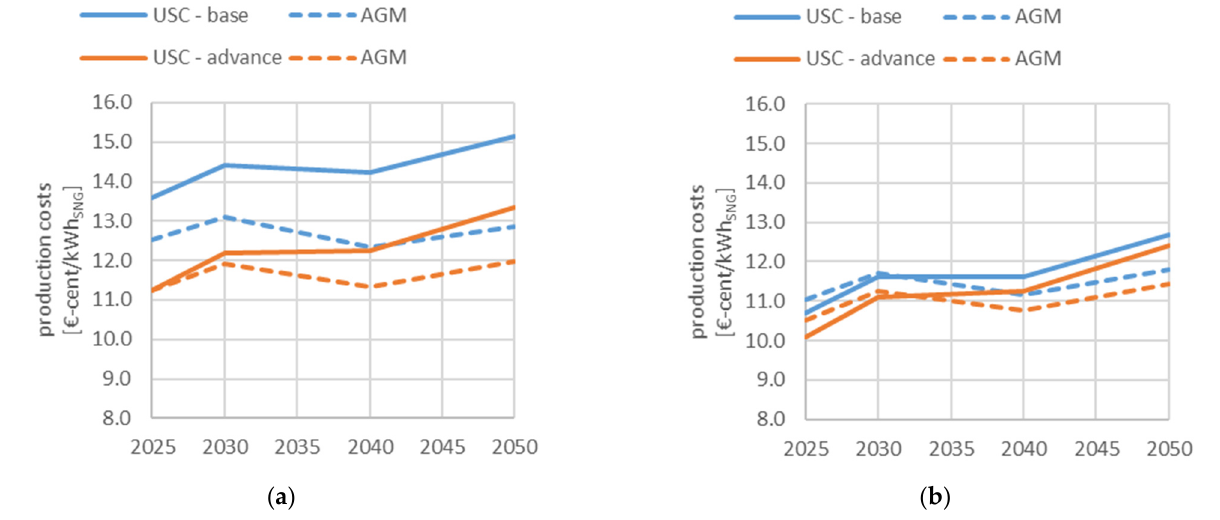
Figure 14. Geomethane production costs. ( a ) plant size 25,000 Nm³/h ( b ) plant size 100,000 Nm³/h.